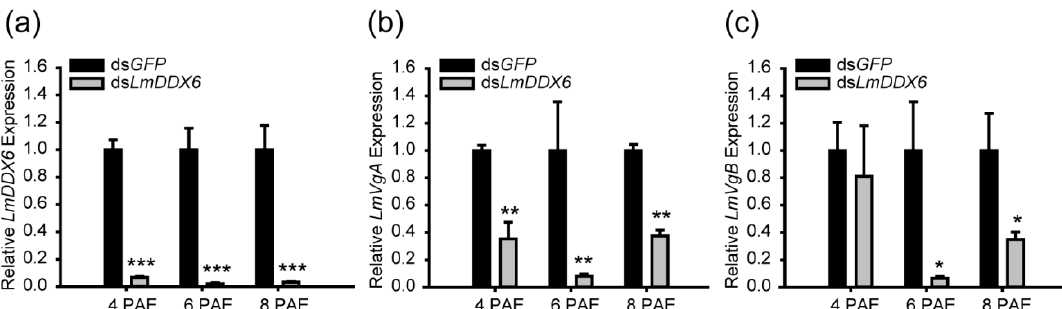
Figure 5. Effect of LmDDX6 depletion on the expression of the vitellogenin ( Vg ) gene. ( a ) LmDDX6 RNA interference efficiency in the fat body of ds LmDDX6 -injected adult females compared with that in ds GFP -injected controls. ( b , c ) Relative expression levels of LmVgA ( b ) and LmVgB. ( c ) The mRNA in the fat body of female adult locusts after LmDDX6 knockdown compared with the corresponding levels in the ds GFP -injected group. Data in all panels are presented as the mean ± standard error of the mean ( n = 8 – 12). Statistical significance of differences is indicated as follows: * p < 0.05; ** p < 0.01; *** p < 0.001.